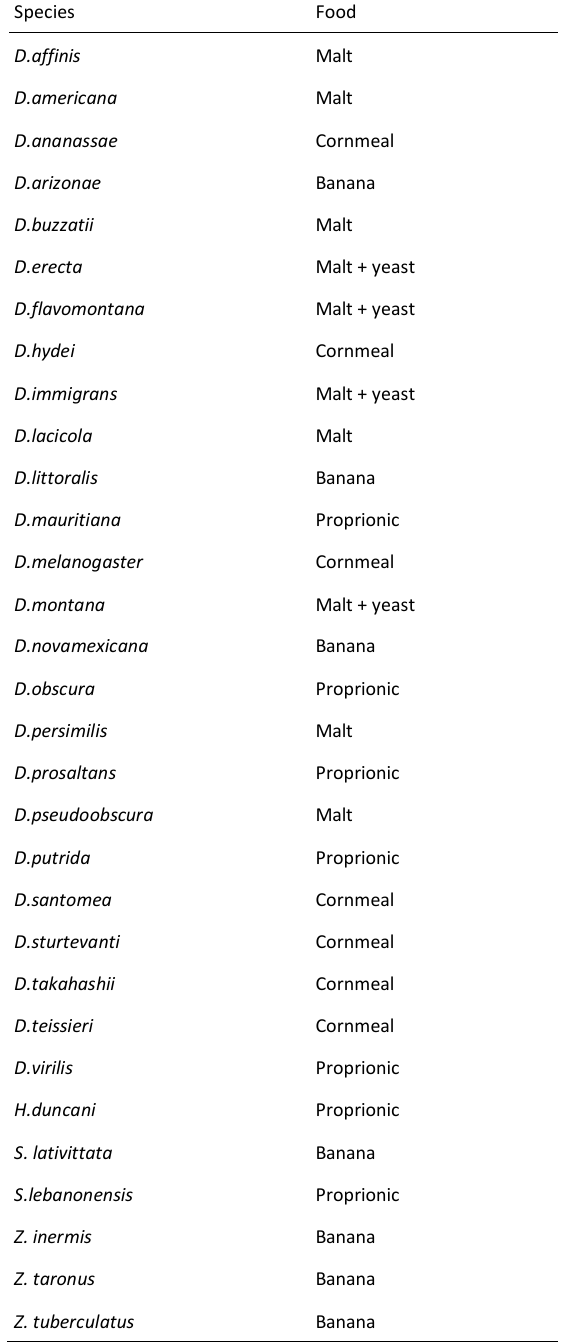
Table S1: Full list of species used in the sex difference experiment and their rearing food for stock populations. All cornmeal and proprionic medium have dried yeast sprinkled onto the surface of the food, other food types do not unless stated below. The recipes for the food types are described